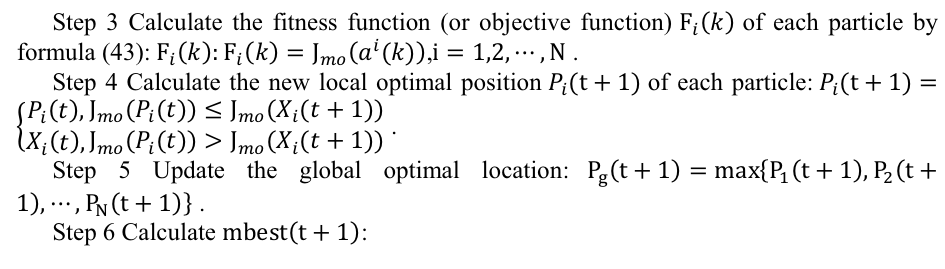
Fig. 2. Trajectory planning flow chart of FFSR manipulator based on QPSO.